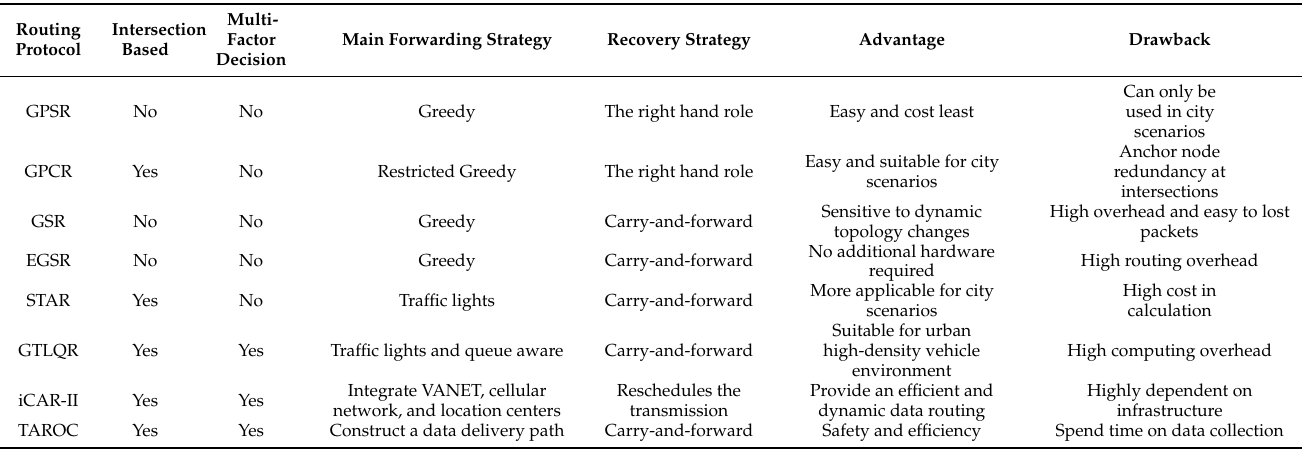
Table 1. Summary of related routing